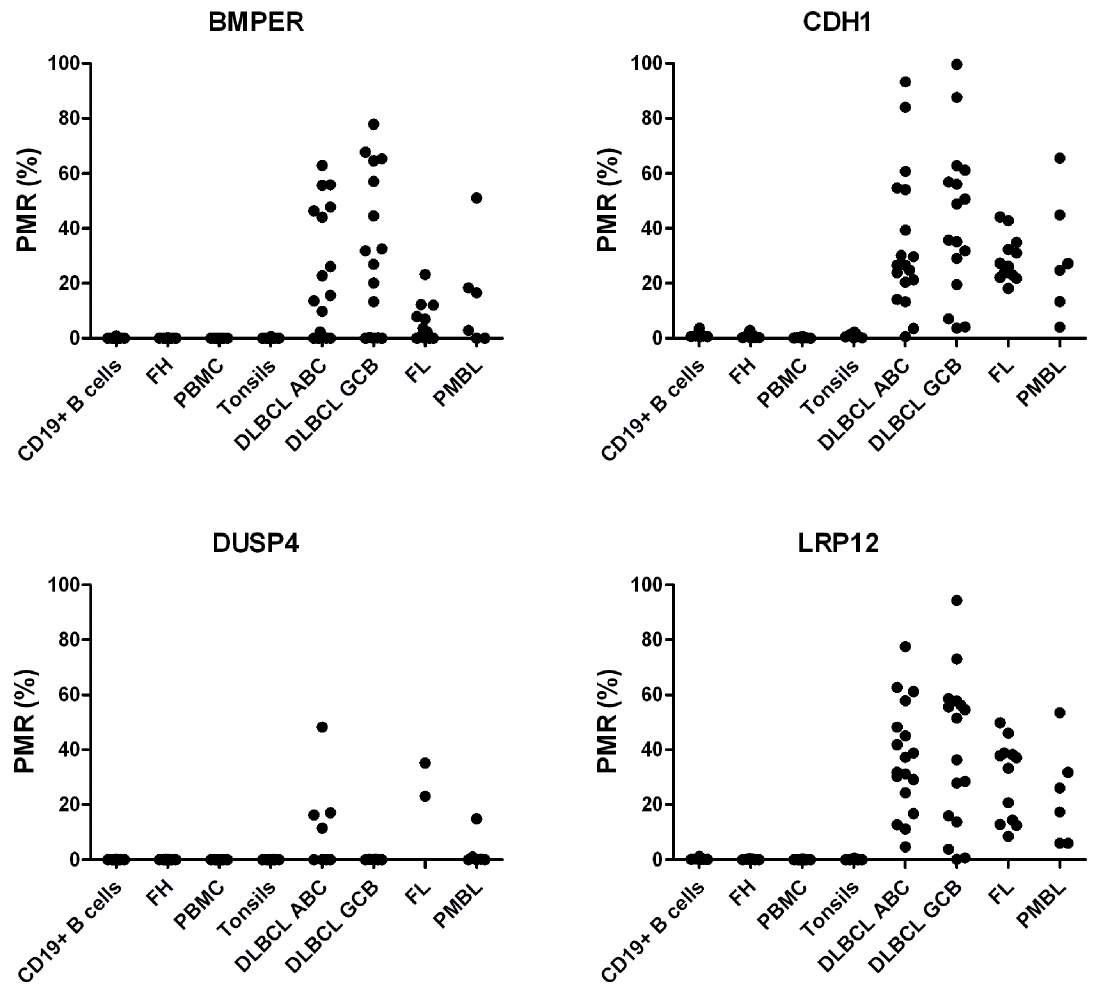
Figure 2. Methylation status of BMPER,CDH1,DUSP4 and LRP12 assessed by qMSP. Percent promoter methylation in control samples (CD19 + B cells, PMBC, tonsils); follicular hyperplasia samples (FH) and lymphoma patient samples. Each dot represents one sample. Abbreviations: BL, Burkitt’s lymphoma; DLBCL ABC, activated B-cell like diffuse large B-cell lymphoma; DLBCL GCB, germinal centre B-cell like diffuse large B-cell lymphoma; FL, follicular lymphoma; and PMBL, primary mediastinal B-cell lymphoma; PMR, percent methylated reference.